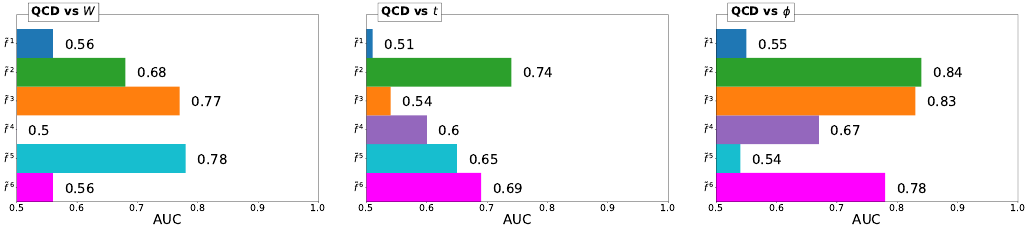
Figure 7 . The AUC for all three signal classes corresponding to each latent dimension in the net-